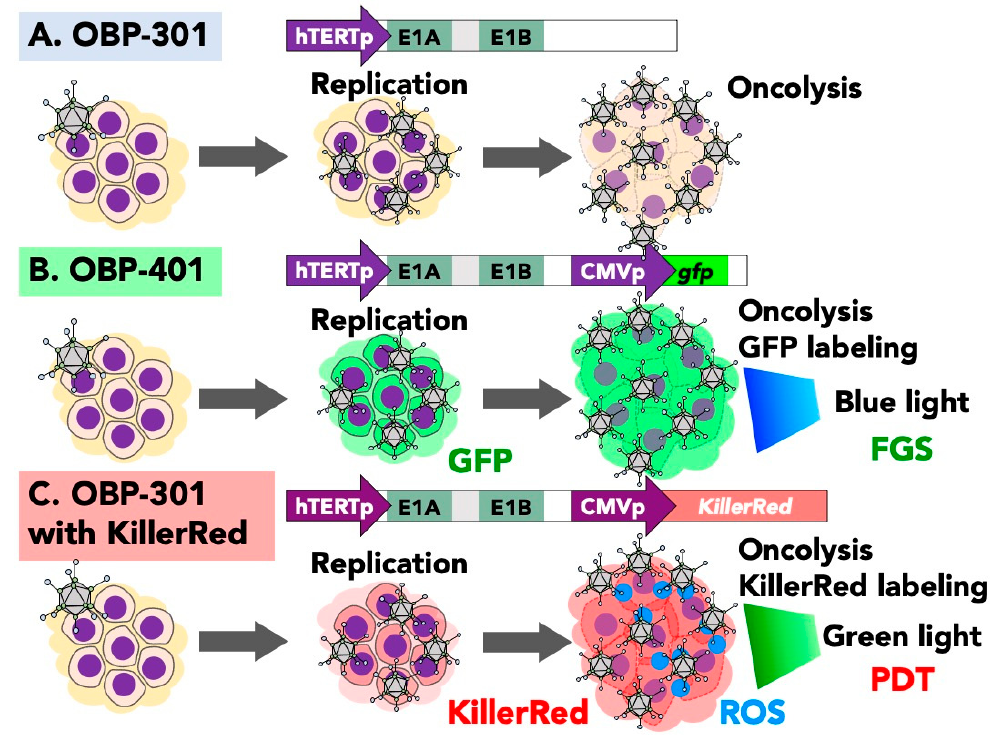
Figure 1. Telomerase-specific conditionally-replicating oncolytic adenoviruses. ( A ) OBP-301 is driven by the hTERT promoter for preferential replication in cancer cells. OBP-301 replicates preferentially in cancer cells that have high expression of telomerase. OBP-301 induces cancer-specific cell death after replication. ( B ) OBP-401 contains a cassette comprising of a CMV promoter and green fluorescent protein ( GFP ) gene. OBP-401 preferentially labels cancer cells with GFP and then kills them, depending on the multiphcity of infection. ( C ) OBP-301 with KillerRed contains a cassette comprising the CMV promoter and KillerRed gene. This virus preferentially labels cancer cells with KillerRed. OBP-301 with KillerRed has a dual function of adenovirus-mediated cancer-cell killing and PDT.